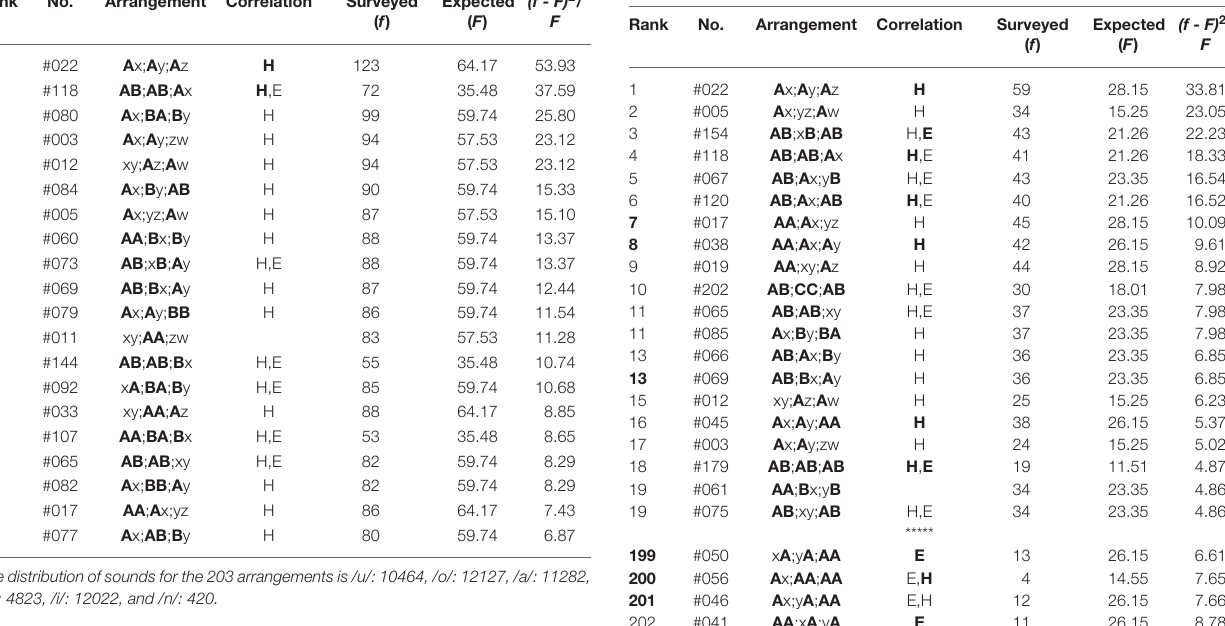
TABLE 6 | The bottom-twenty arrangements in The Complete Haiku Works of Seishi Yamaguchi, wherein there are 8523 poems included. Rank No. Arrangement Correlation Surveyed